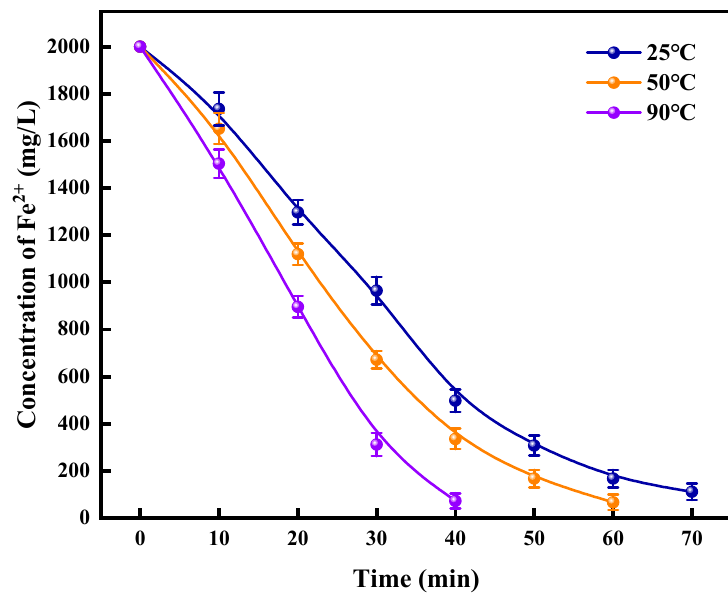
Figure 3. Influence of different temperatures on the oxidation of ferrous ions.